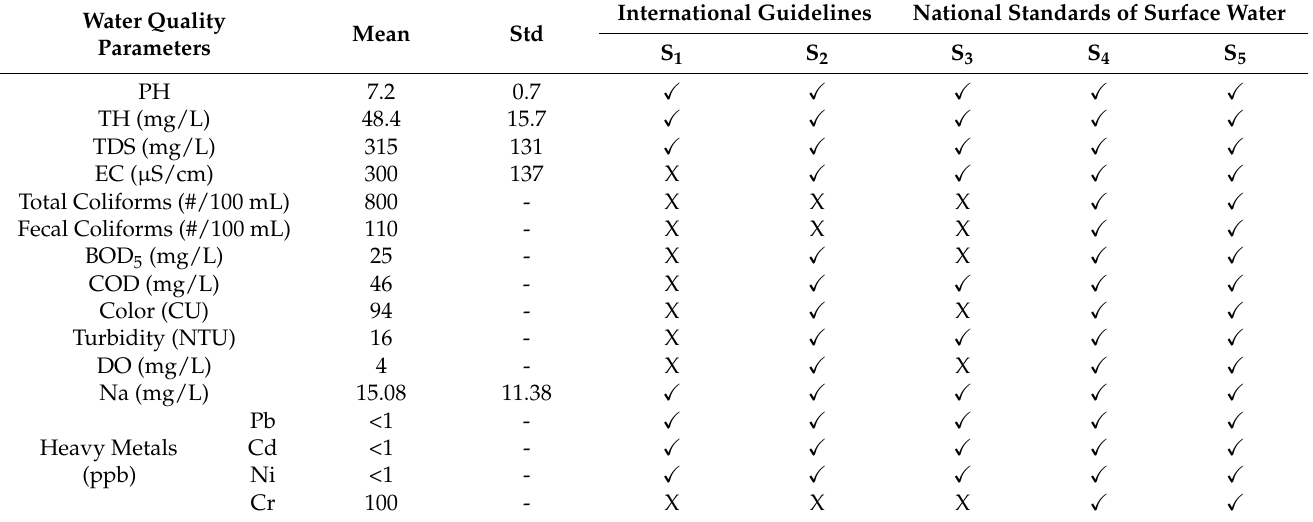
Table 4. Checklist of evaluating quality of the sampled water measurements with respect to the suggestions of the selected standards of different consumption